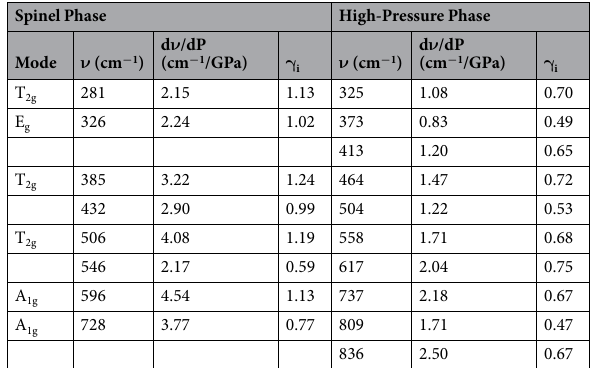
Table 1. Observed Raman-mode frequencies ( ν ), pressure dependences (d ν /dP), and calculated mode Grüneisen parameters ( γ i ) for Mg 2 TiO 4 at pressure to 50 GPa. The high-pressure tetragonal phase was collected from 24.3 GPa to 50